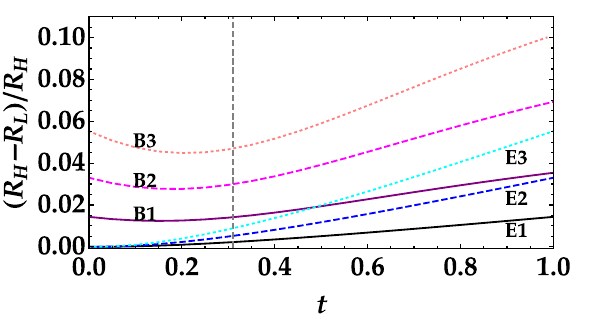
Figure 9. Relative difference between the noise reduction factor measured for high and low mean values of the thermal state as a function of the transmittance efficiency t . For all cases 0.2 , blue and magenta dashed lines to m H lines correspond to � � = 0.4 . Black, blue and cyan lines refer to Eve, while purple, magenta, and pink to Bob. The vertical line m H to � � = t ∗ , that is the threshold value over which Bob measures R > 1 corresponds to t =